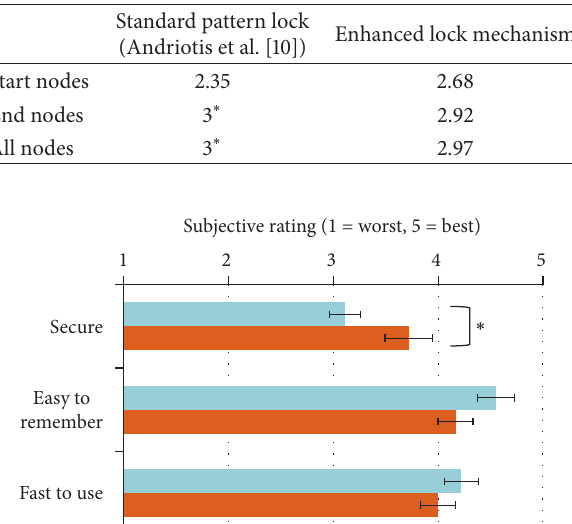
Table 2: Shannon entropy for nodes used in the lock pattern. A value of 3.00 indicates that there is no bias towards particular nodes and that all nodes are used equally. ∗ = exact values not provided.